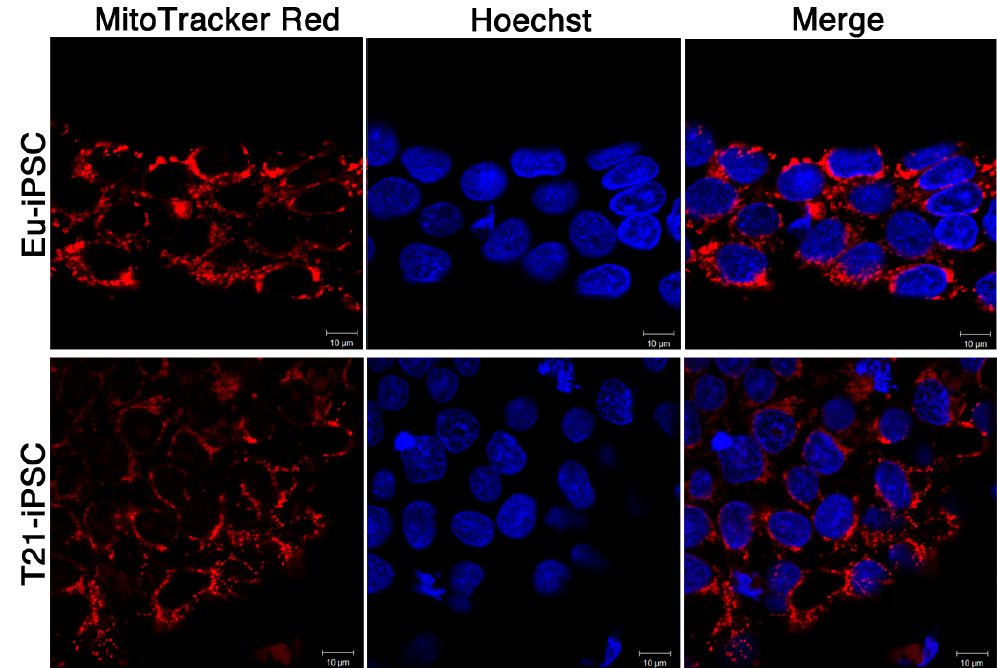
Figure 9. Organization of the mitochondrial network in euploid and trisomic iPSCs. Confocal microscopy representative images of the MitoTracker Red-related fluorescence of euploid and trisomic iPSC clones. MitoTrackerRed probe stains mitochondria (red). Nuclei are stained with Hoechst (blue). Bar = 10 μ m.